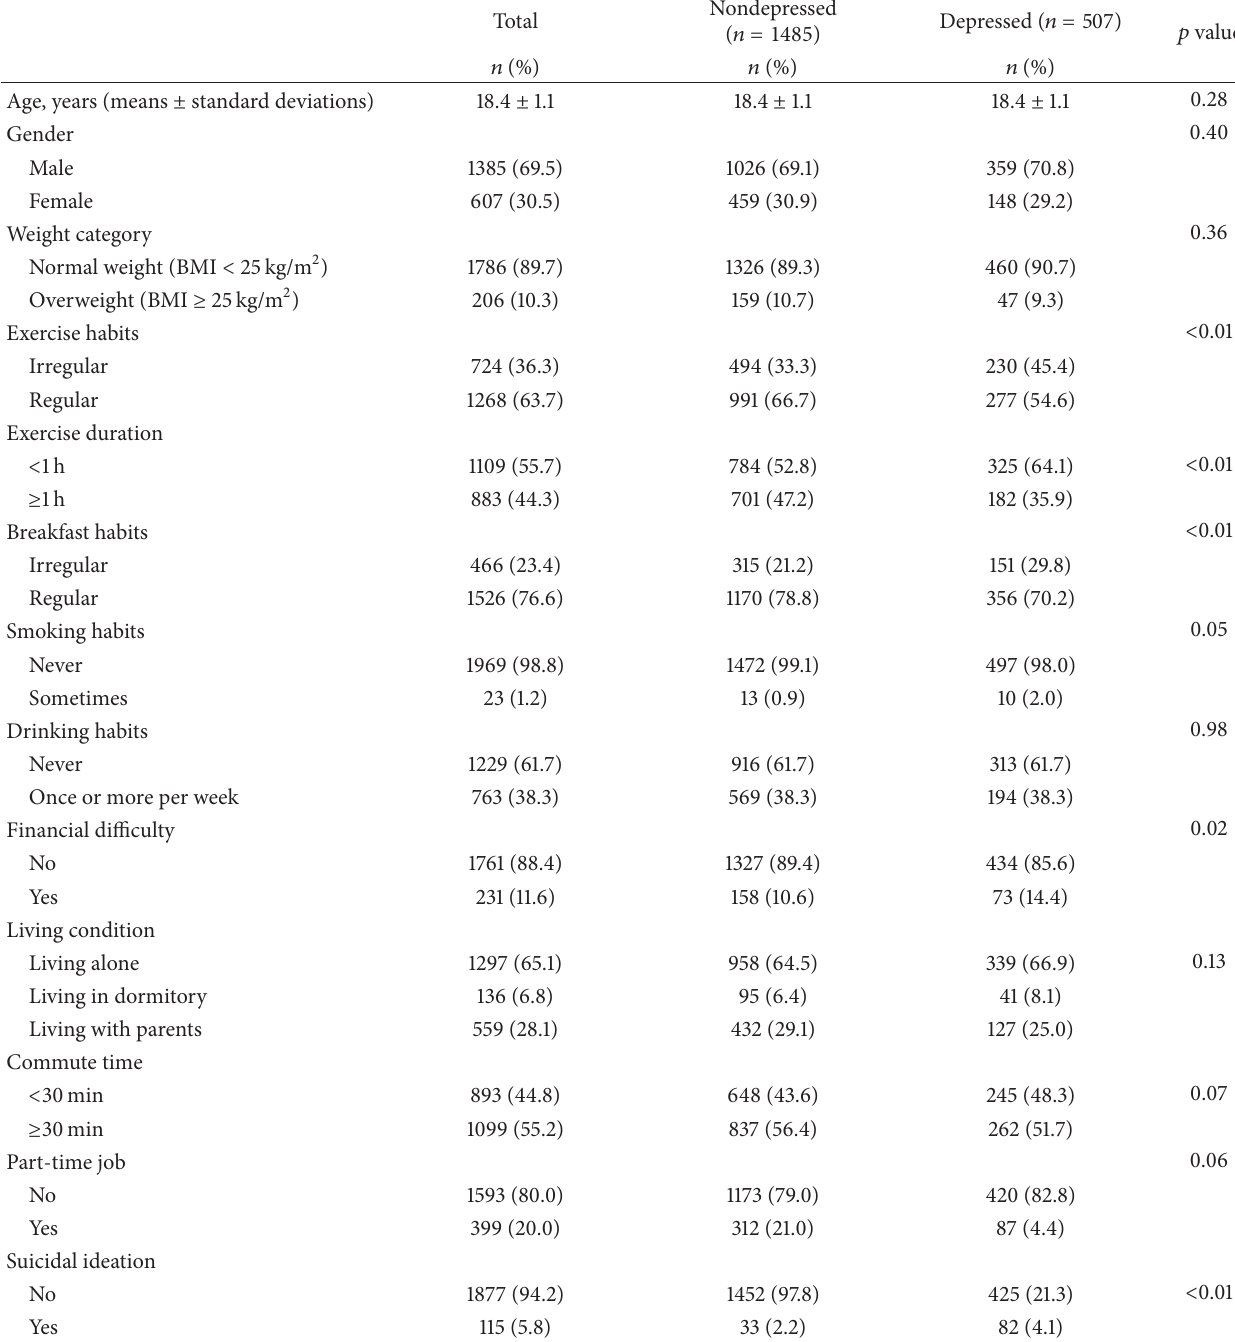
Table 1: The characteristics of study participants with and without the depressive